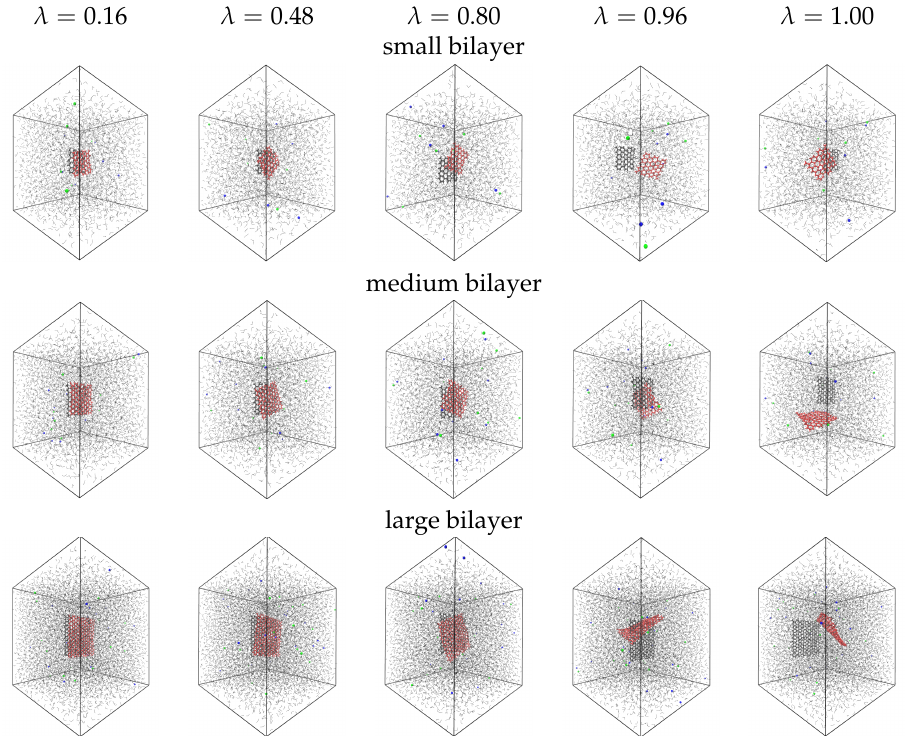
Figure 1. Configurations of the decoupling simulations of small, medium and large bilayer graphene samples at different values of the decoupling parameter, λ . As λ increases, the van der Waals interactions of the decoupled graphene layer decrease. The decoupled graphene layer is colored in red and the reference in black. Water molecules are shown with lines. Na + and Cl − ions are shown with red and blue spheres. The time-frame of the presented configurations is